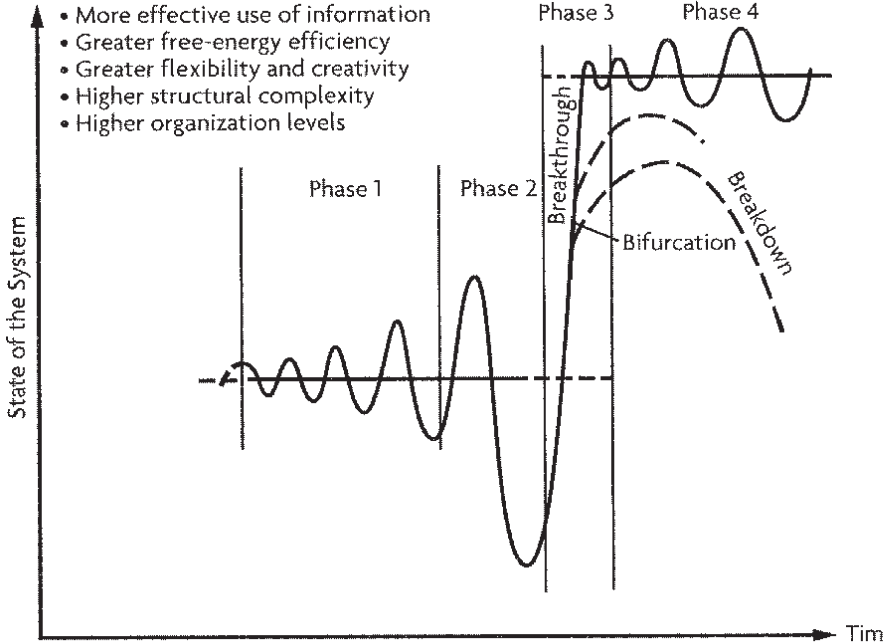
Figure 1: The four phases of a Macroshift (Laszlo